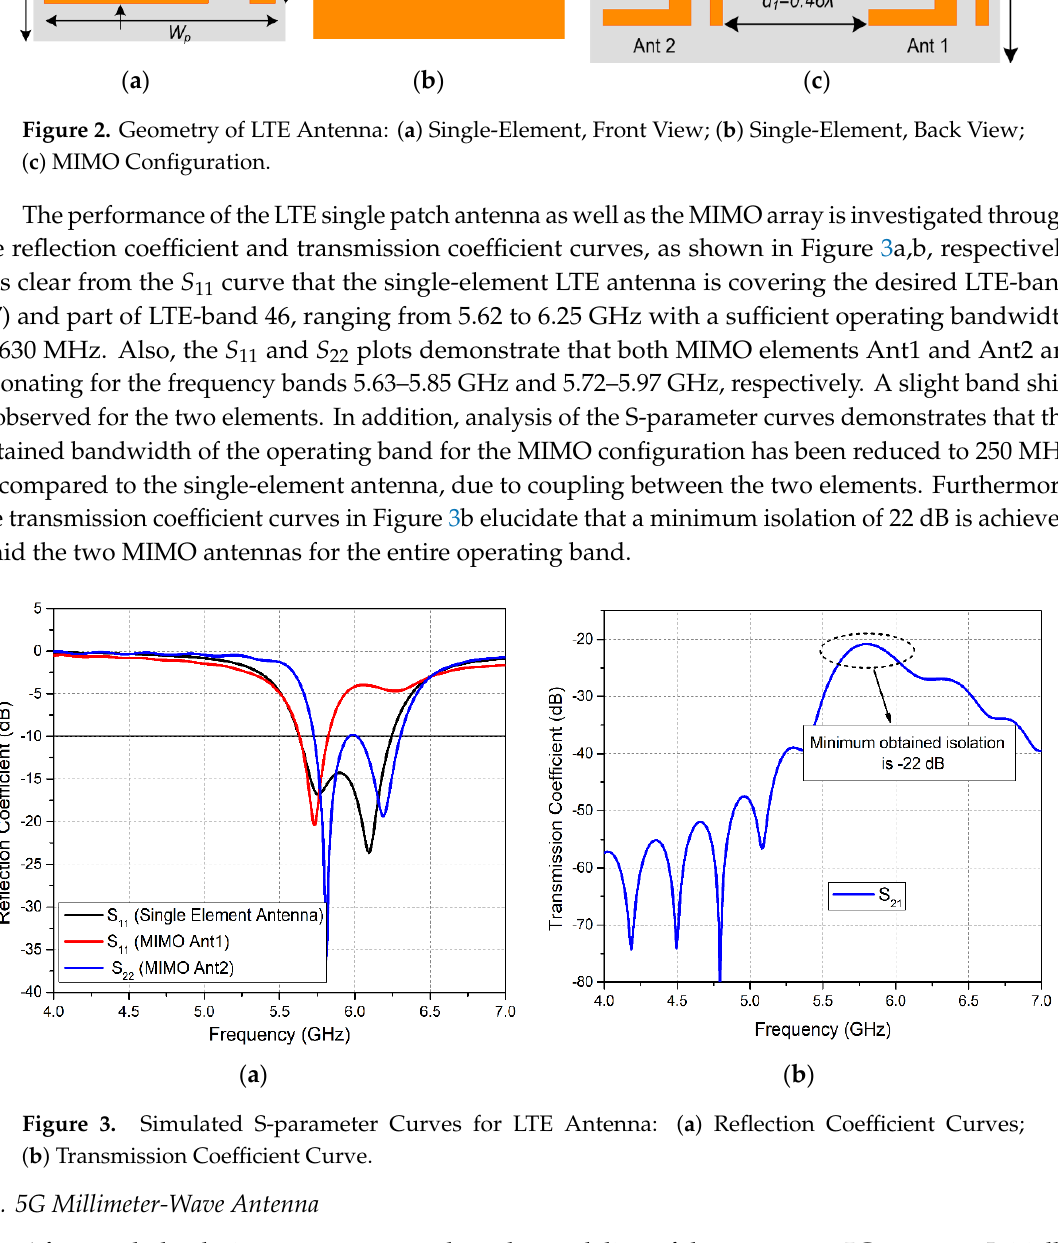
Table 1. Optimized Parametric Values of the Proposed Design.